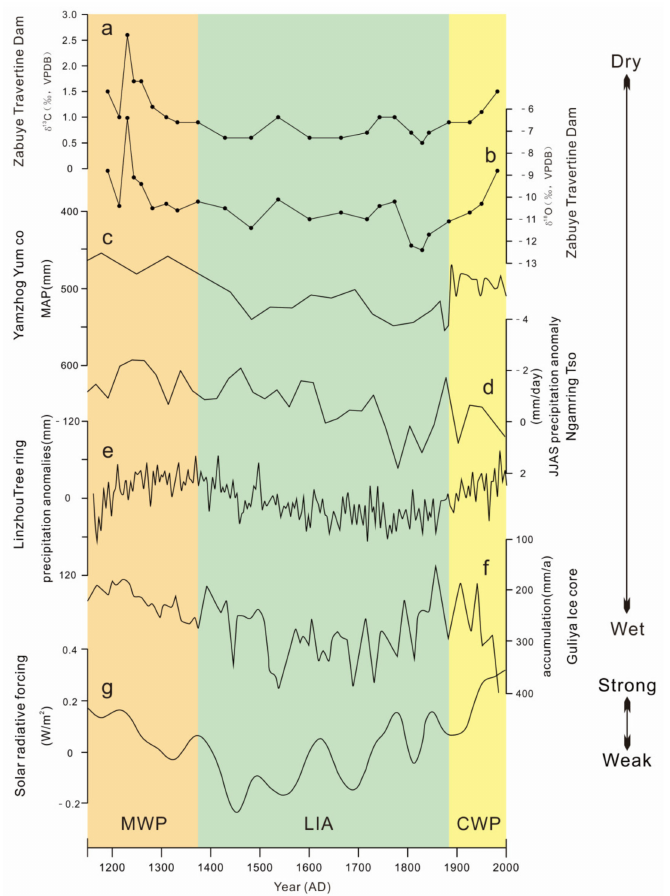
Figure 8. Comparison of climatic records from Zabuye Salt Lake travertine dam with other climatic records. ( a ) Carbon isotopes of carbonate of travertine dam. ( b ) Oxygen isotopes of carbonate. ( c ) Mean annual precipitation (MAP) at Yamzhog Yumco Lake [11]. ( d ) June to September (JJAS) precipitation at Ngamring Tso [13]. ( e ) Tree ring precipitation anomalies at Linzhou [7]. ( f ) Ice core accumulation at Guliya [41]. ( g ) Solar radiative forcing [85]. MWP, LIA, and CWP refer to Medieval Warm Period, Little Ice Age, and Current Warm Period,